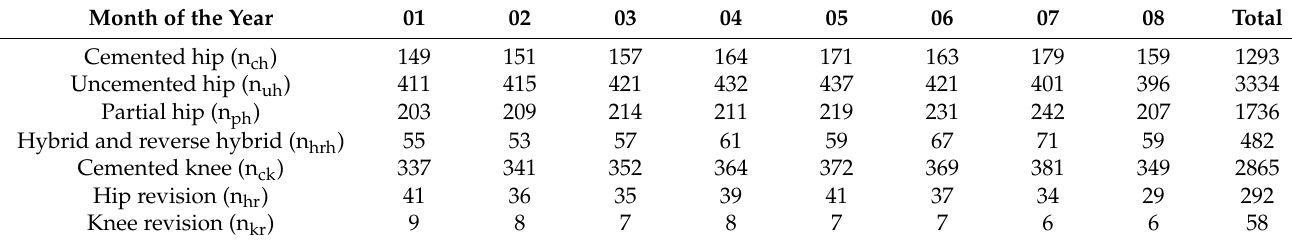
Table 5. Number of cases in 2022 until 1